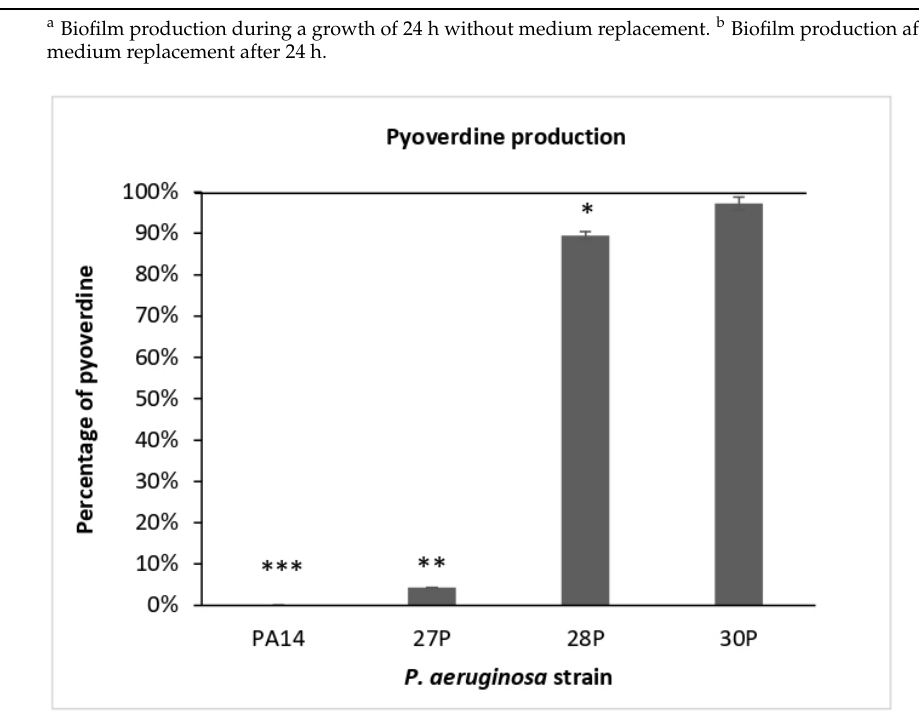
Figure 5. Effect of SPEP on pyoverdine produced after 48 h of growth. Data are reported as a percentage of pyoverdine production in the presence of SPEP in comparison with controls (bacteria grown in King’s B Medium supplemented with 0.5% ( w/v ) of CAA). Each data point is composed of 4 independent experiments, each performed in at least 3 replicates. Error bars indicate the standard deviations of all the measurements. Statistical differences were determined by the Student’s t -test: * p < 0.05; ** p < 0.01, *** p < 0.001, compared with the control.